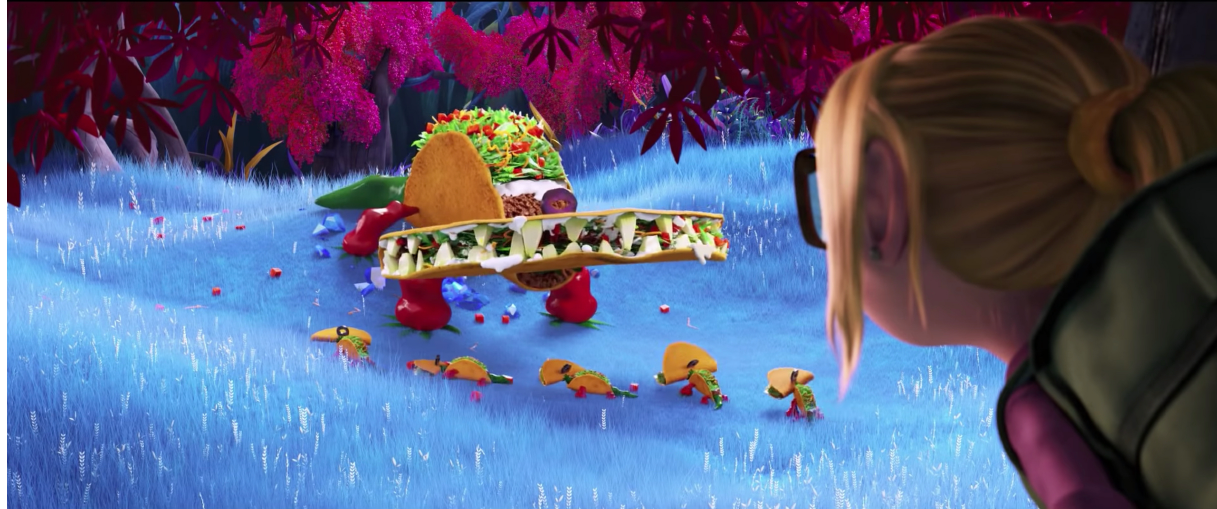
Figure 3: Sam Sparks observes the Tacodile Supreme shepherding her cubs to safety (Cloudy 2).